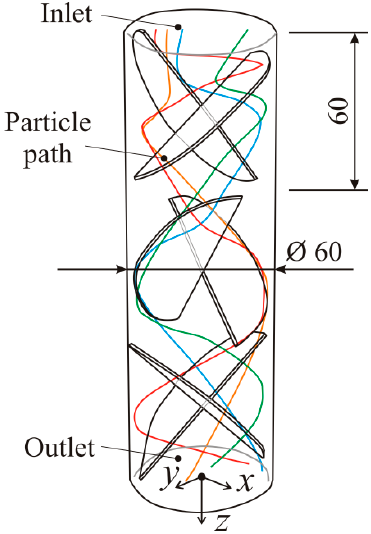
Figure 1. Komax-type vertical static mixer, with three blending elements.